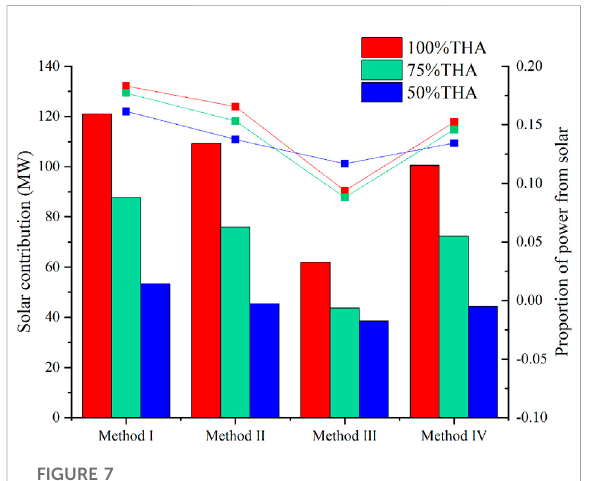
FIGURE 7 Solar contribution with different evaluation methods in the TSACPG system under 100% THA, 75% THA, and 50% THA loads.